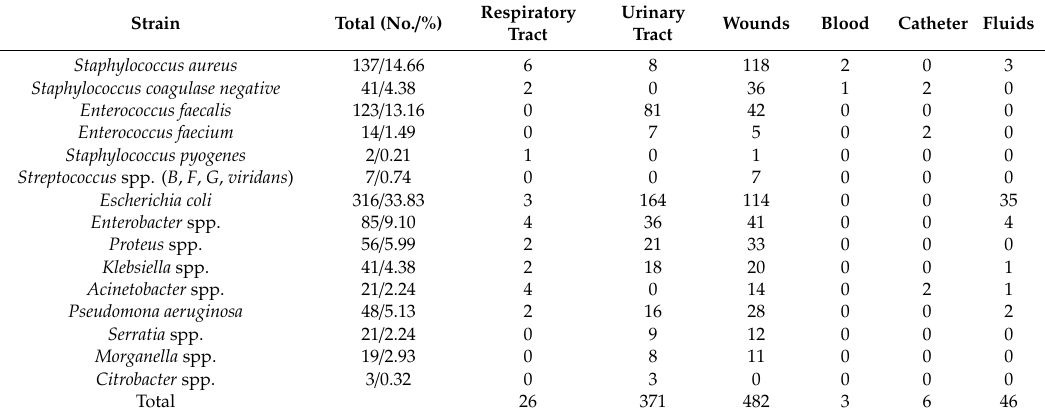
Table 4. Number and frequency (%) of the isolated pathogens. Strain